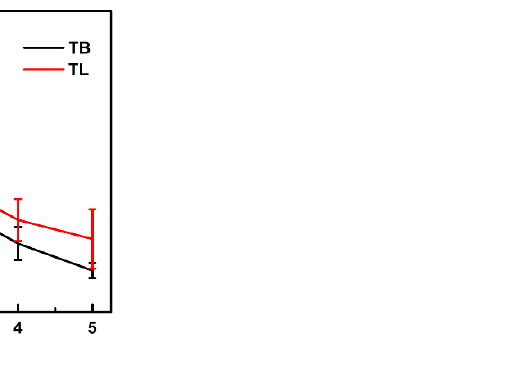
Figure 10. Bending rigidities of TB- and TL-bound bilayer membranes at various peptide concen- trations.